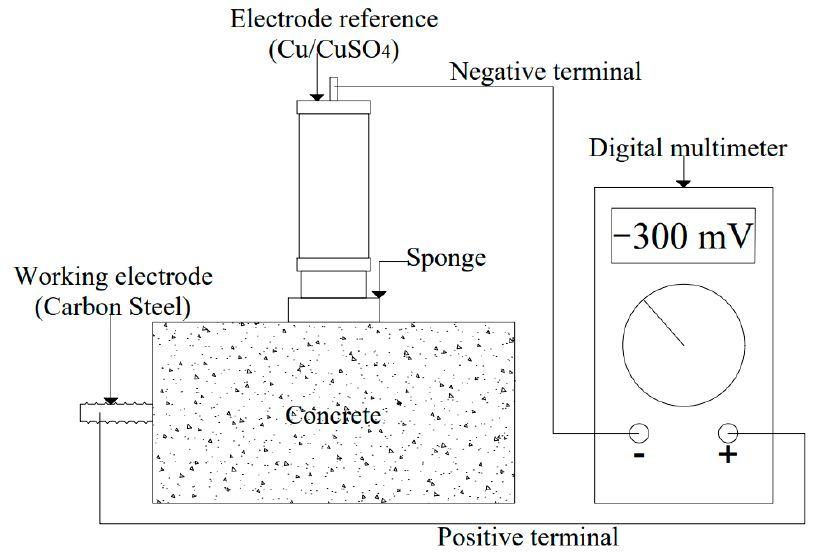
Figure 4. Setup for the measurement of half-cell potential according to ASTM C 876. Table 7. Corrosion probability percentages for corrosion potentials with Stratful criteria [40,42]. mV vs. CSE